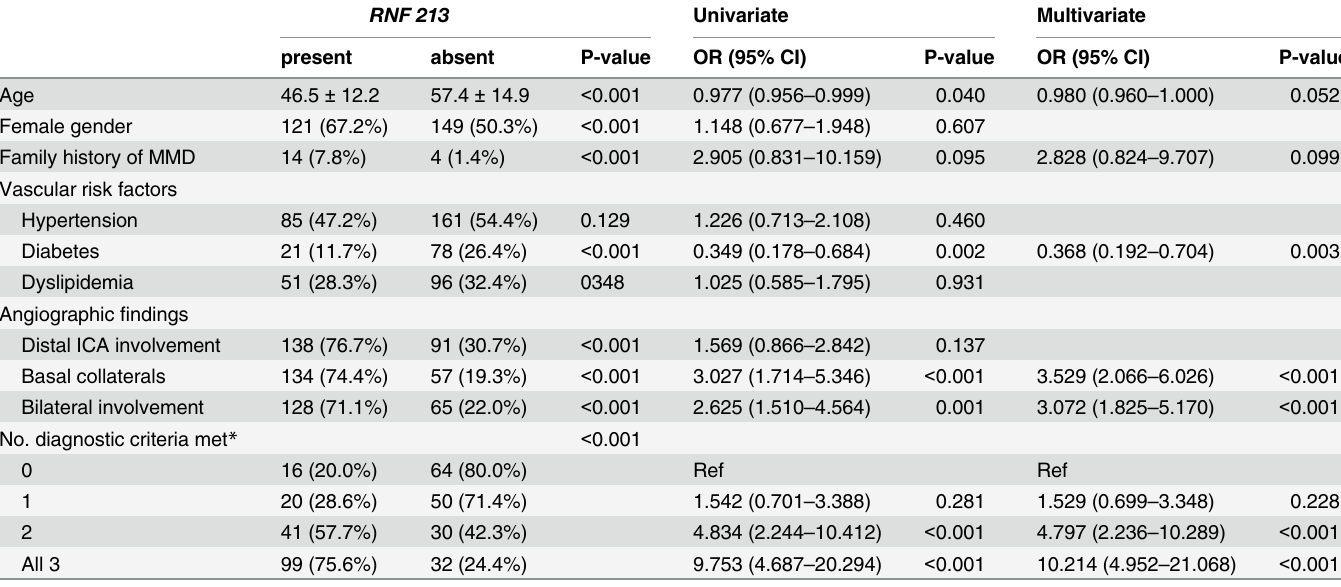
Table 2. Factors predicting the genetic variant of RNF213 associated with MMD among 352 patients with intracranial arterial stenosis.